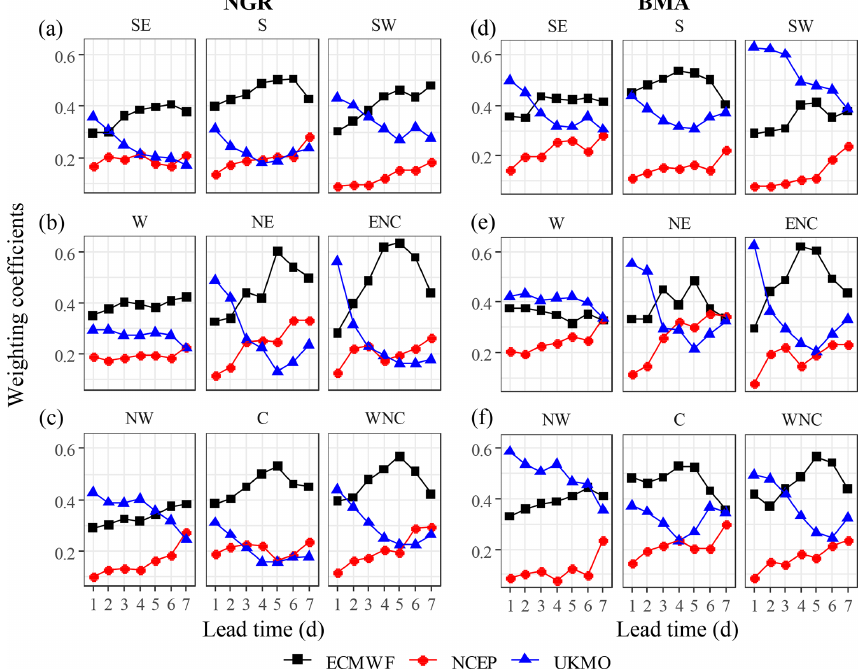
Figure 5. Regional mean weighting coefficient b of the NGR technique (a–c) and the weighting coefficient w of the BMA technique (d–e) for the post-processed daily ECMWF-NCEP-UKMO forecasts at different lead